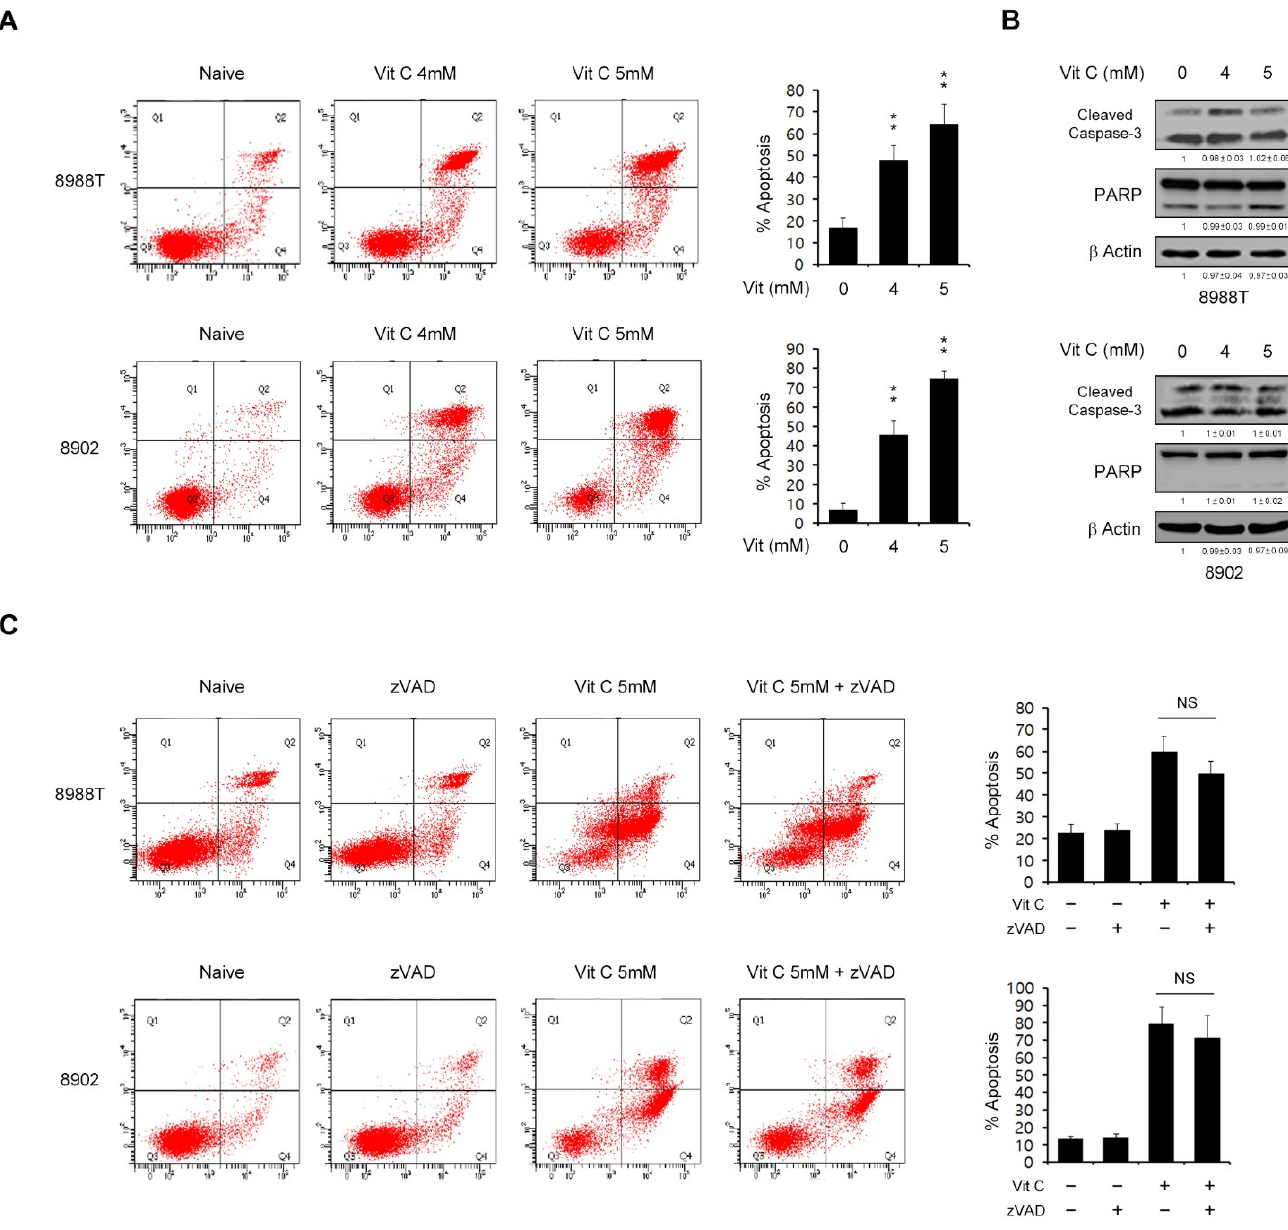
Figure 2. High-dose vitamin C enhances the caspase-independent apoptosis response of PDAC cells. ( A ) PDAC cells were treated with vitamin C (4 or 5 mM) for 24 h and assayed for apoptotic cell death by annexin V/PI staining and flow cytometry. ( B ) PDAC cells were treated with vitamin C (4 or 5 mM) for 24 h and immunoblotted with the indicated antibodies. Error bars with the mean ± s.d. of three independent experiments. ( C ) PDAC cells were treated with vitamin C (4 or 5 mM) for 24 h with or without zVAD-fmk (50 µ M) and assayed for apoptotic cell death by annexin V/PI staining and flow cytometry. Error bars represent the s.d. of triplicate wells from representative experiments; ** p < 0.01. NS, not significant.